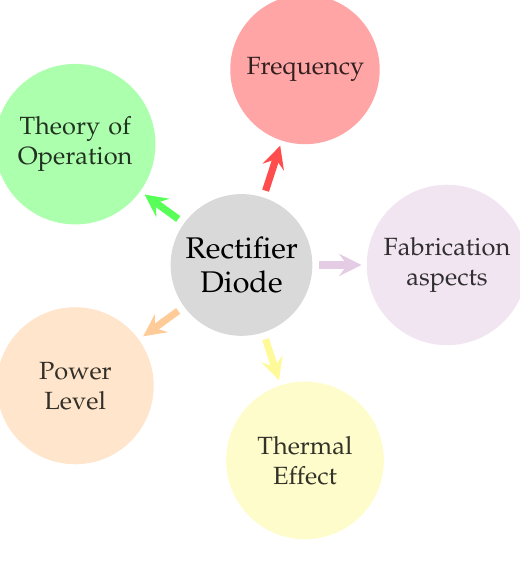
Figure 3. Factors affecting the rectifier diode